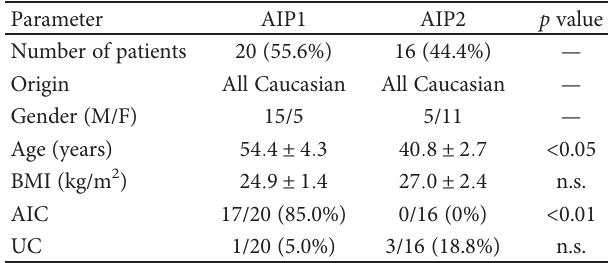
Table 1: Demographic and clinical characteristics of our study population with AIP1 and AIP2 (n.s. = not signi fi cant) [BMI,